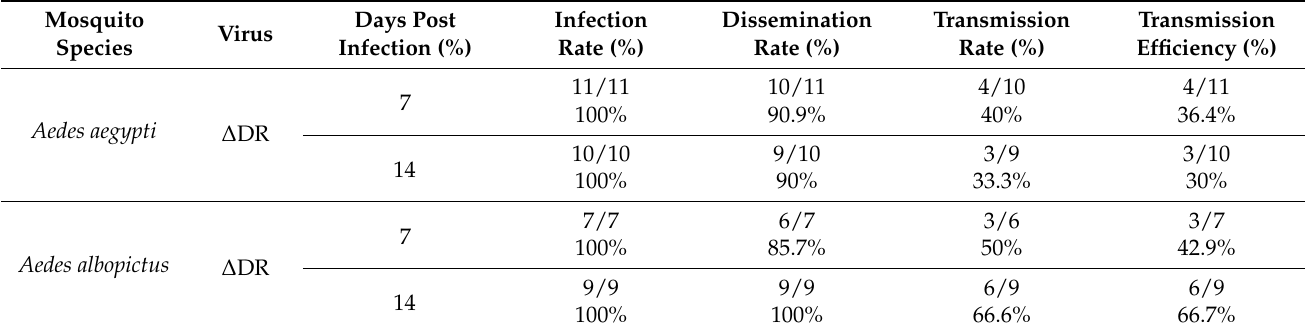
Table 2. Infection, dissemination, transmission rates, and transmission efficiencies for CHIKV- ∆ DR at d7 and d14 post infection in Ae. aegypti and Ae. albopictus. Mosquito